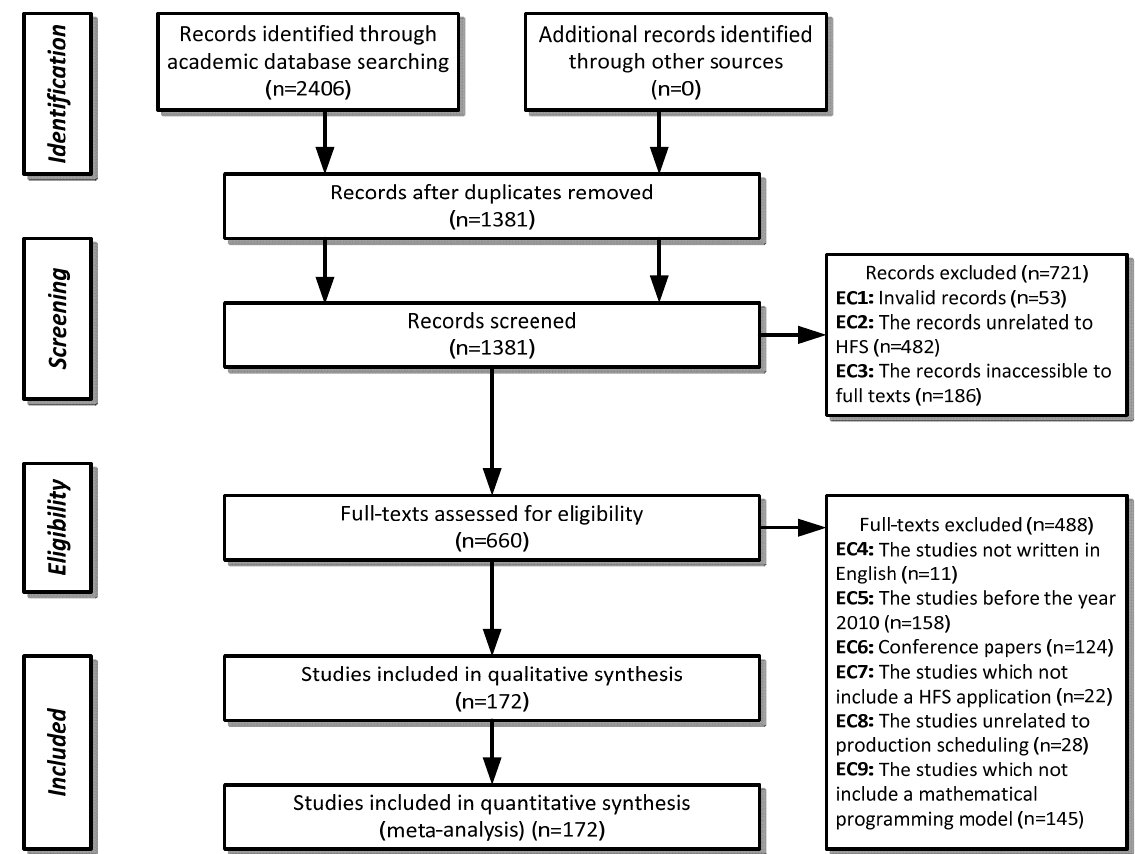
Fig. 2. A flowchart for the review process including steps of PRISMA